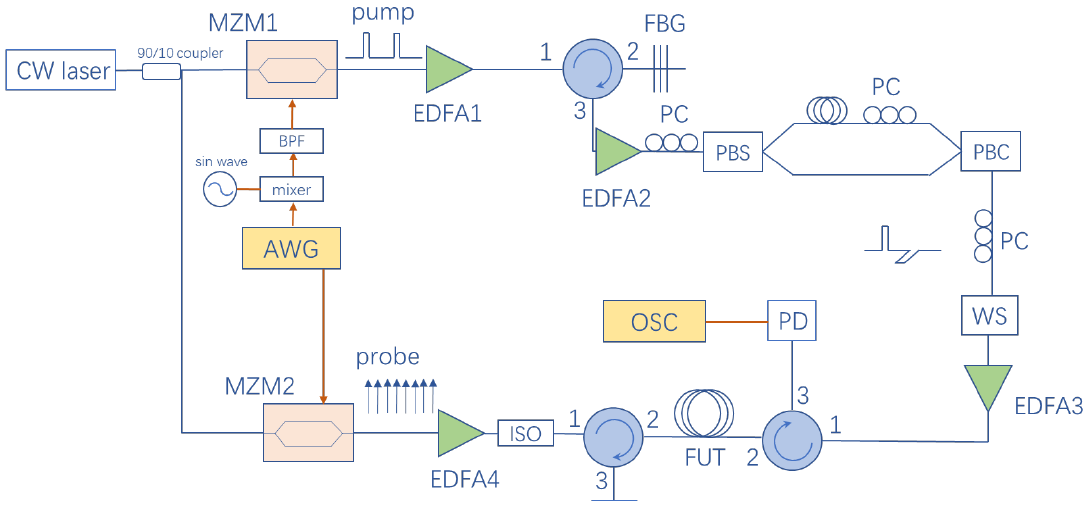
Figure 4. Experimental setup of the proposed BOTDA sensing system. CW laser: Continuous-wave laser; MZM: Mach–Zehnder modulator; EDFA: Erbium-doped optical fiber amplifier; FBG: Fiber Bragg grating; PC: Polarization controller; PBS: Polarizing beam splitter; WS: Wave-shaper; PBC: Polarizing beam combiner; PD: Photodiode; ISO: Optical isolator; FUT: Fiber under test; OSC: Real-time oscilloscope.